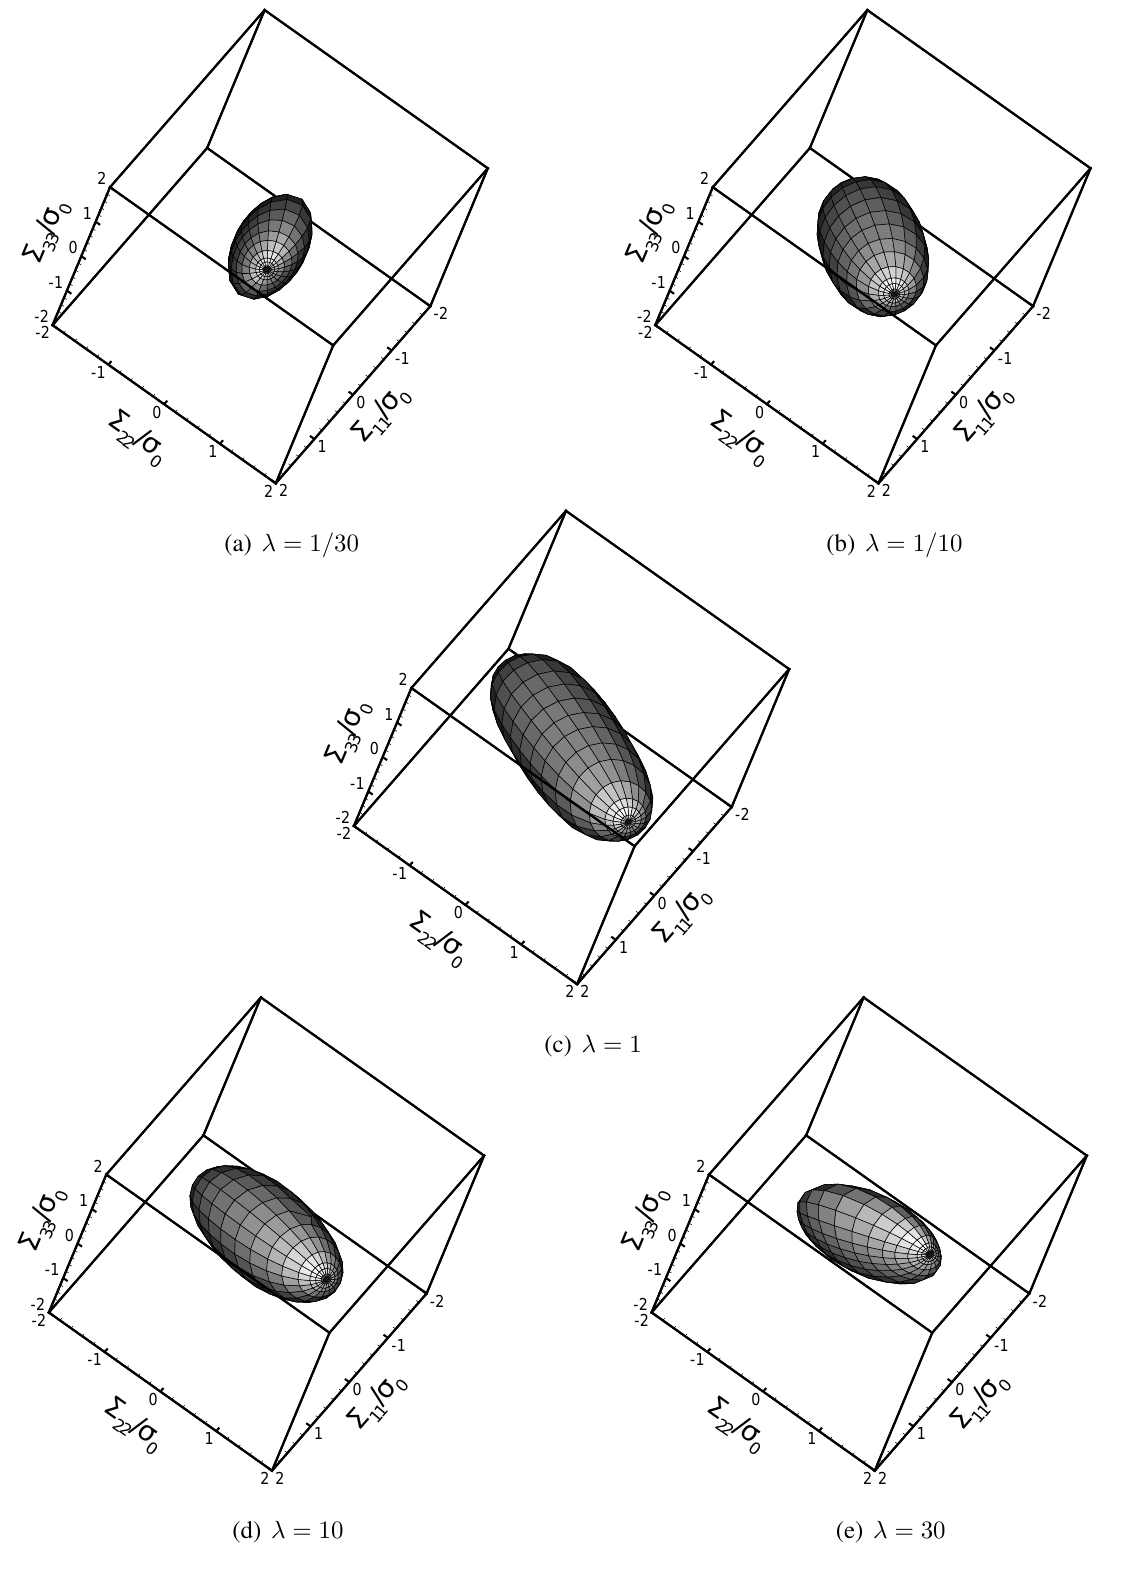
− Σ − Σ space, at varying λ ( f = 0 . 05) 11 22 33